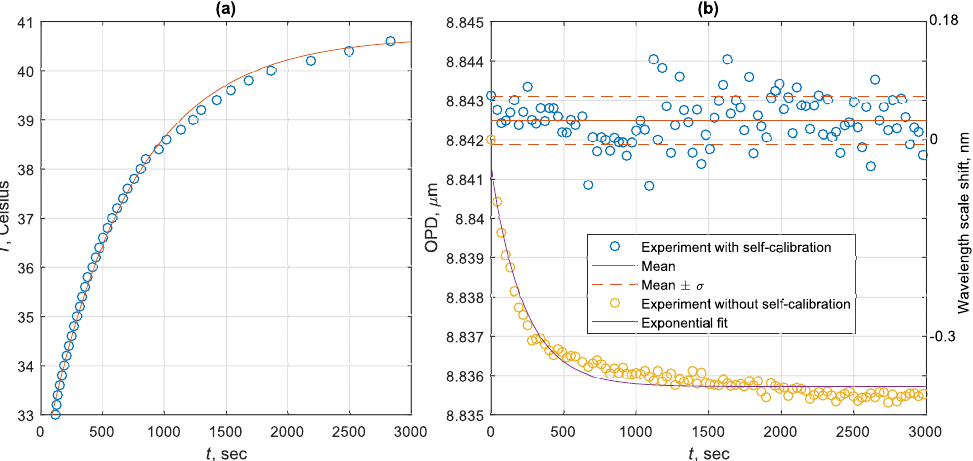
Figure 8. ( a ) Change of the temperature on the smartphone surface during the optical fiber sensor interrogation. Circles—experimental points, curve—exponential fit. ( b ) Curves of demodulated interferometer OPD in case of application of the proposed spectral self-calibration and conventional demodulation with only initial wavelength calibration. Right-hand side vertical axis illustrates the corresponding shift of the wavelength scale. Solid line shows the mean OPD and dashed lines show the standard deviation of the experimental